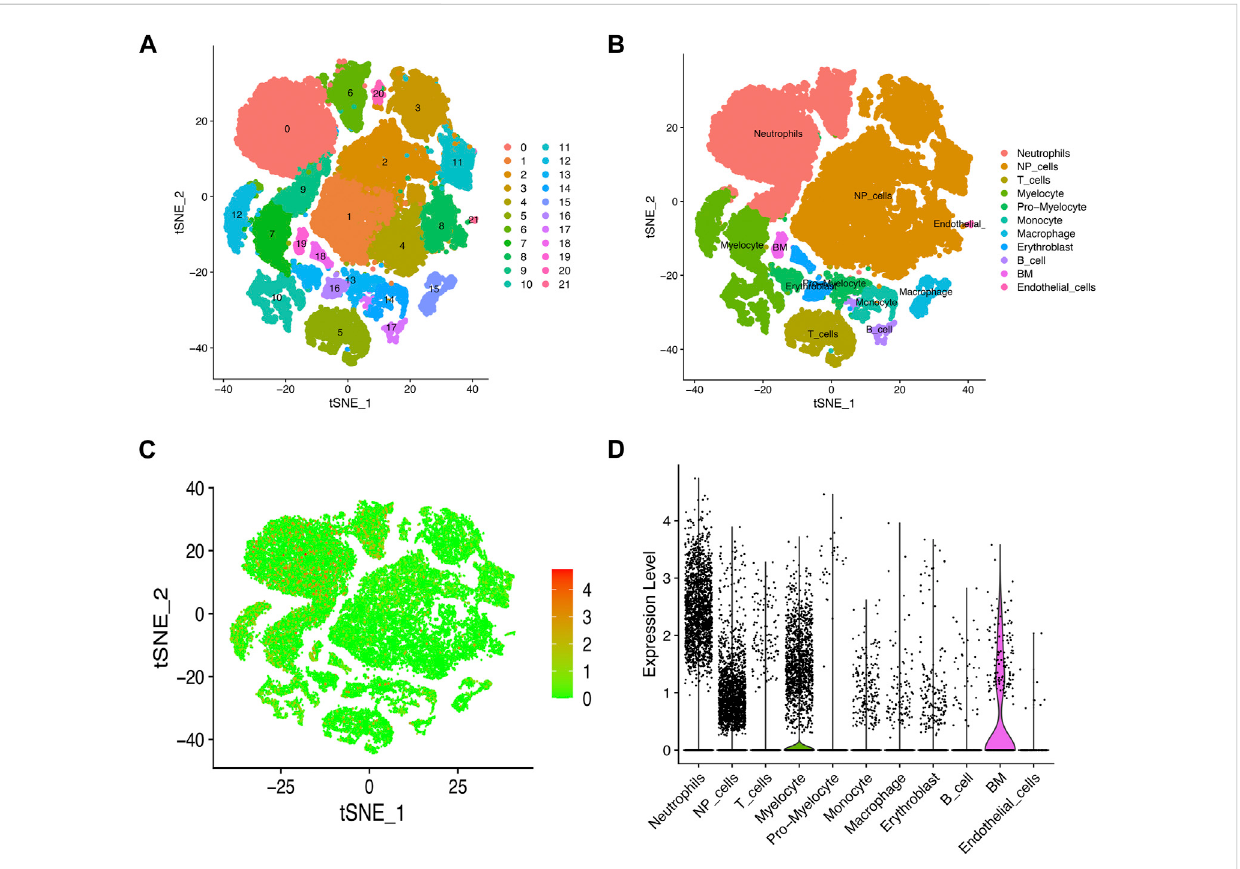
FIGURE 7 Single cell sequencing data analysis and identi fi cation of different cell types. (A, B) t-SNE projections and cell type annotation of IVD tissue. (C, D) t-SNE and violin diagrams demonstrated MFN2 expression pattern at the single-cell